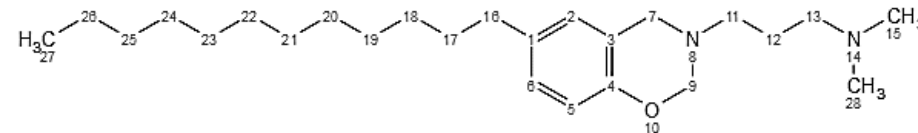
Figure 6. Structure of 6-dodecyl-3-(N,N-dimethylaminopropyl)-3,4-dihydro-2H-[1,3]-benzoxazine with numbered carbon atoms.